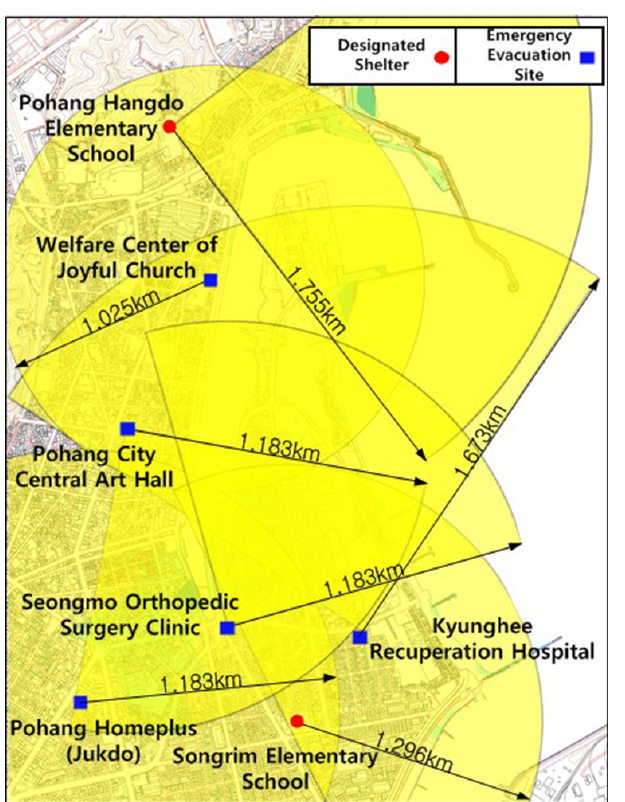
Figure 3. Shelter coverage areas at Pohang Port.